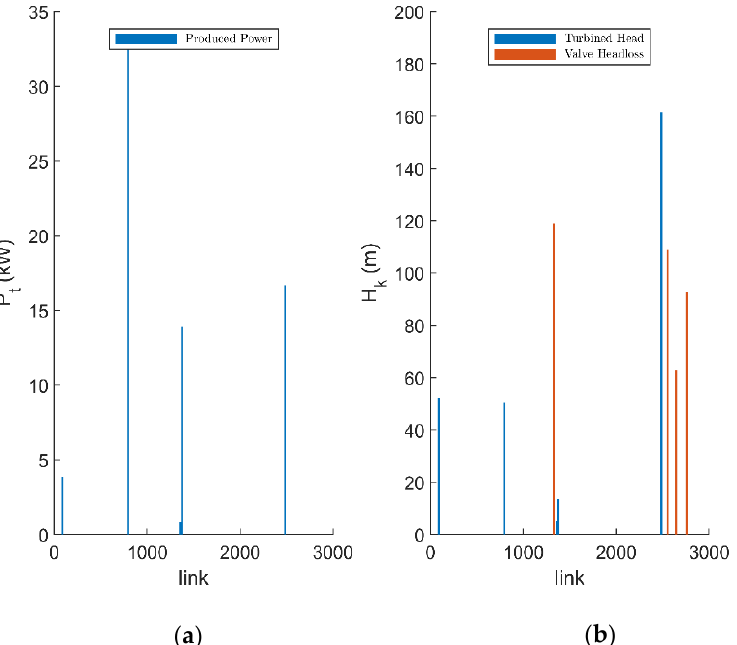
Figure 16. Produced power of the installed turbines ( a ) and head drop within the devices ( b ) resulting from case (I).